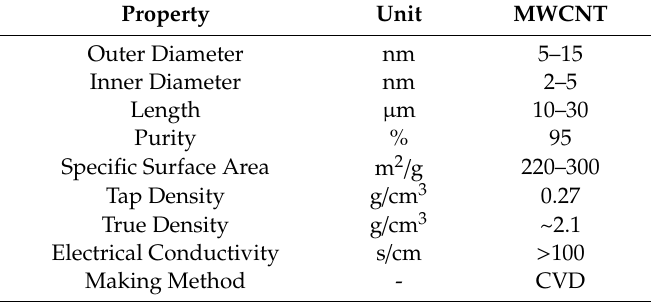
Table 2. Types of specimen involved in this work.